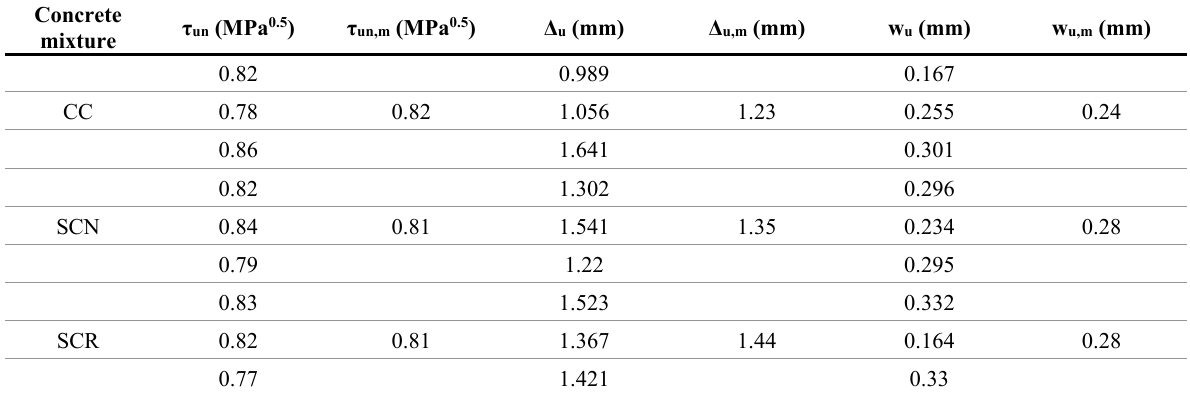
Table 4. Average vertical displacements and crack width at ultimate normalized stress.